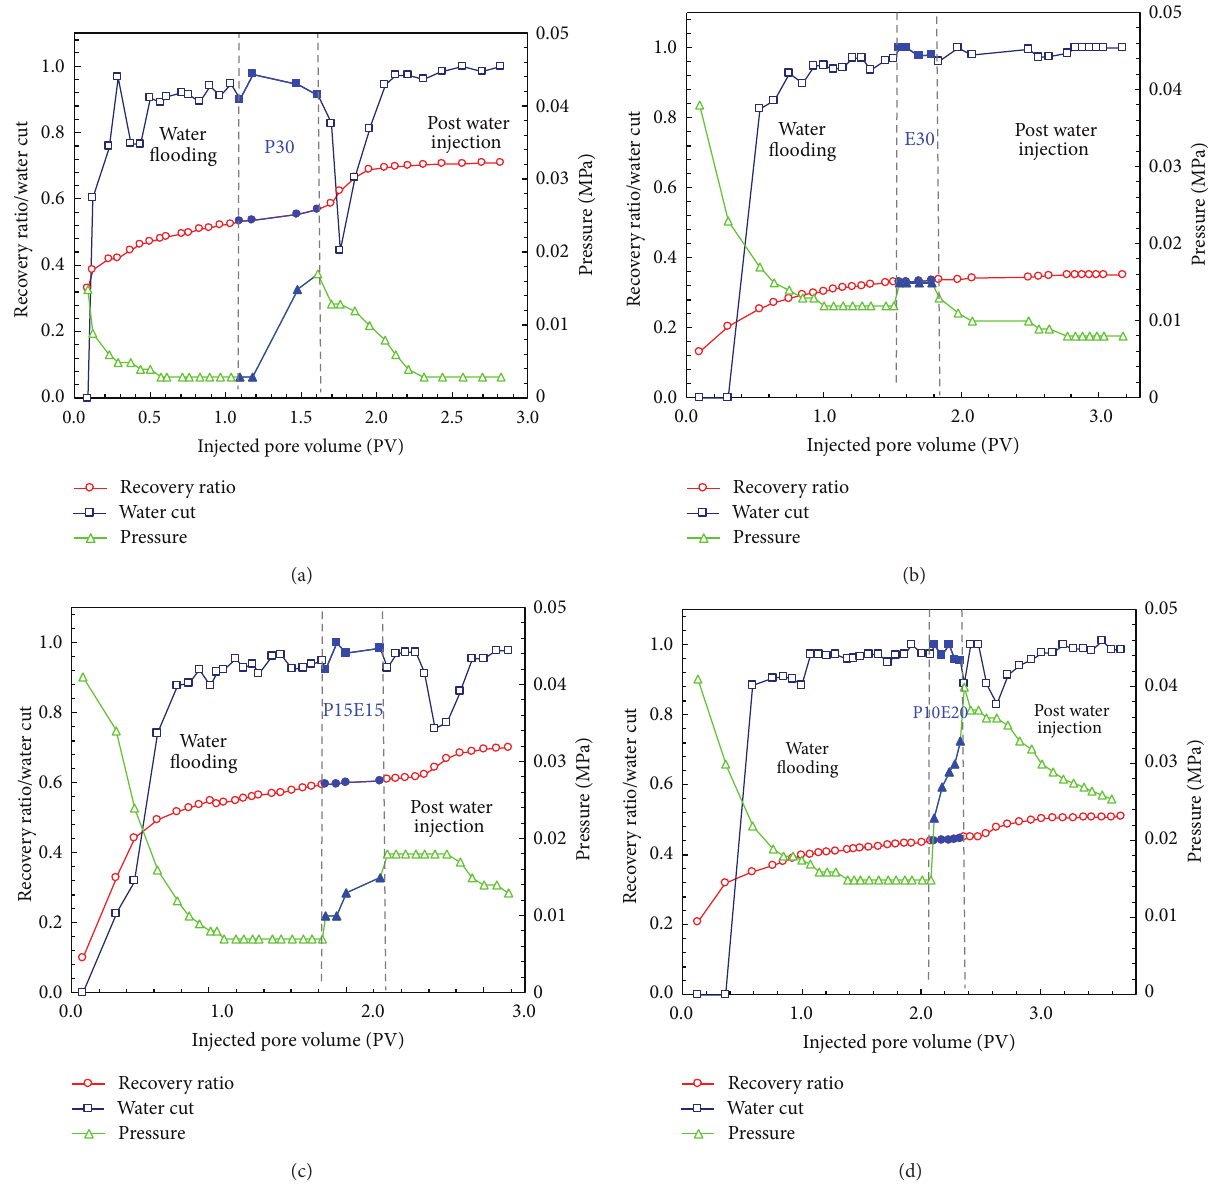
Figure 4: Recovery factor, water cut, and flooding pressure plotted as a function of injected volume of the samples: (a) P30, (b) E30, (c) P15E15, and (d) P10E20 (TDS = 32,868 mg/L, [Ca 2+ ] + [Mg 2+ ] = 873 mg/L; injected volume = 30% PV; injected rate = 0.23 mL/min).